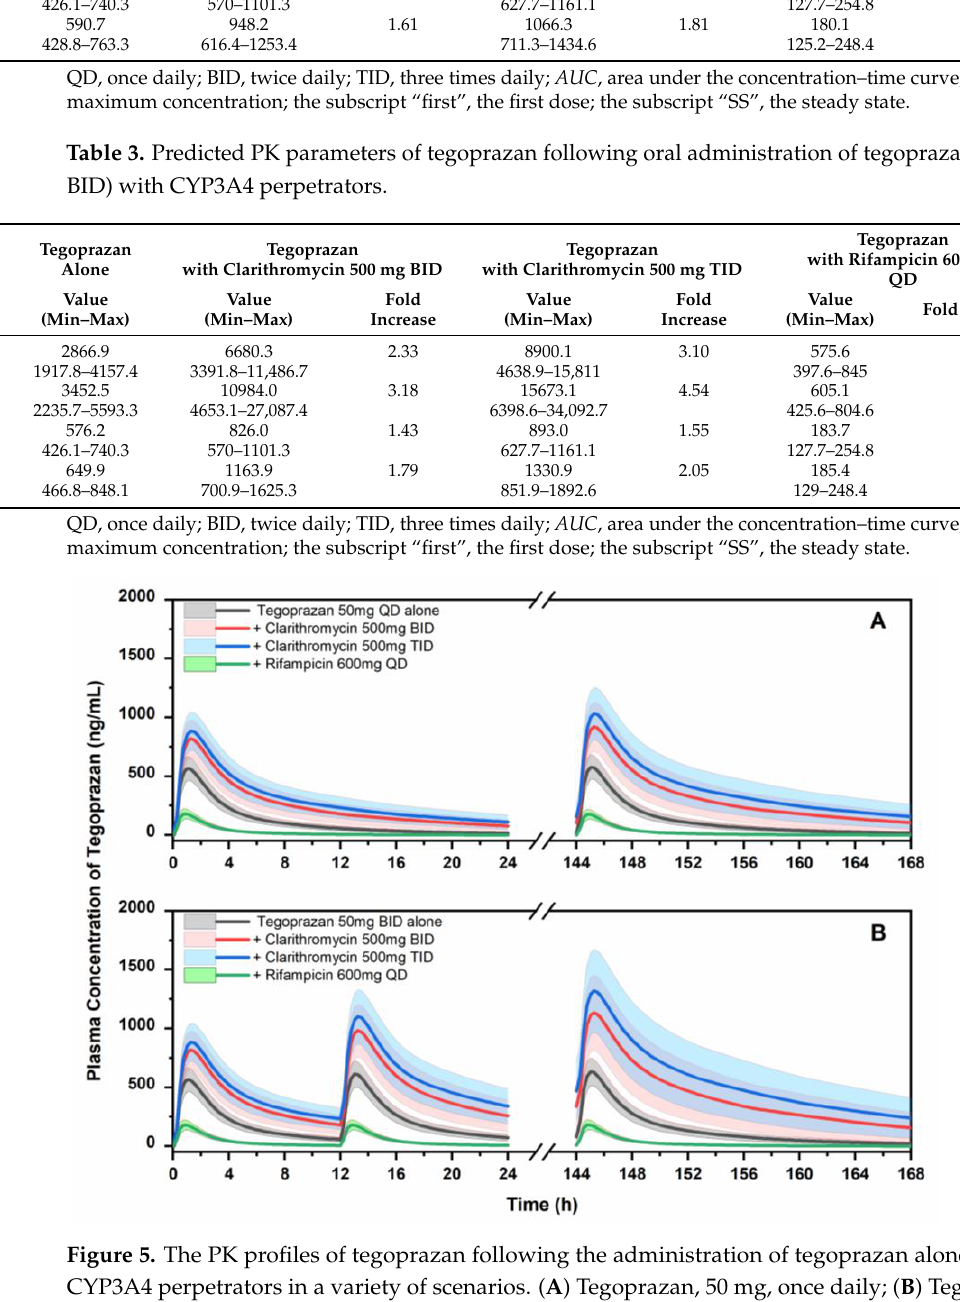
Table 3 . Predicted PK parameters of tegoprazan following oral administration of tegoprazan (50mg, BID) with CYP3A4 perpetrators.